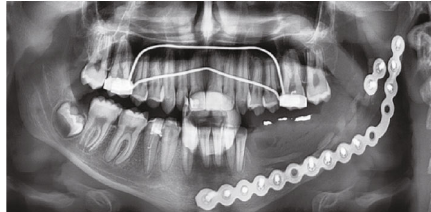
Figure 9: A radiographic image after denture delivery.